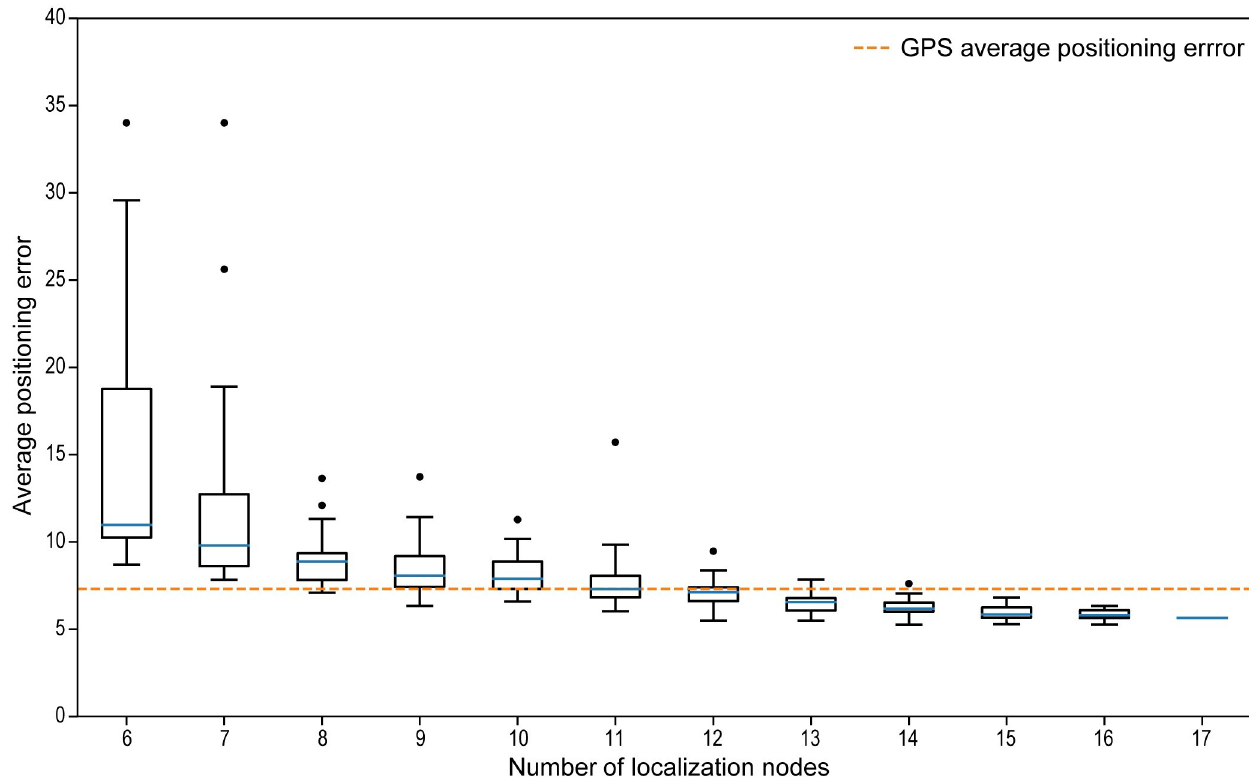
Fig 4. WBN tracking performance versus GPS tracking. Localization errors of a reference path of approximately 300 m by the WBN are shown for different numbers of tracking nodes (6–17) in a deciduous forest of approximately 1.5 ha area. The average positioning error of 4 tracks of a heavy-duty commercial wildlife GPS tracker is shown for comparison by a yellow dashed line. Data and code used to create this figure have been archived by GFBio (https://doi.org/ 10.7479/vd6t-7a92). GPS, global positioning system; WBN, wireless biologging network.